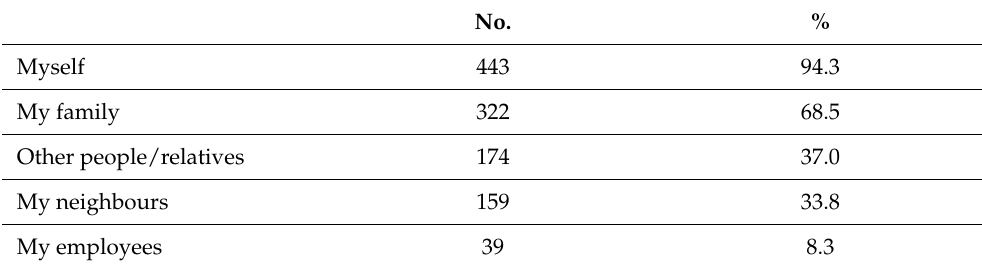
Table 9. People consuming food from the business.